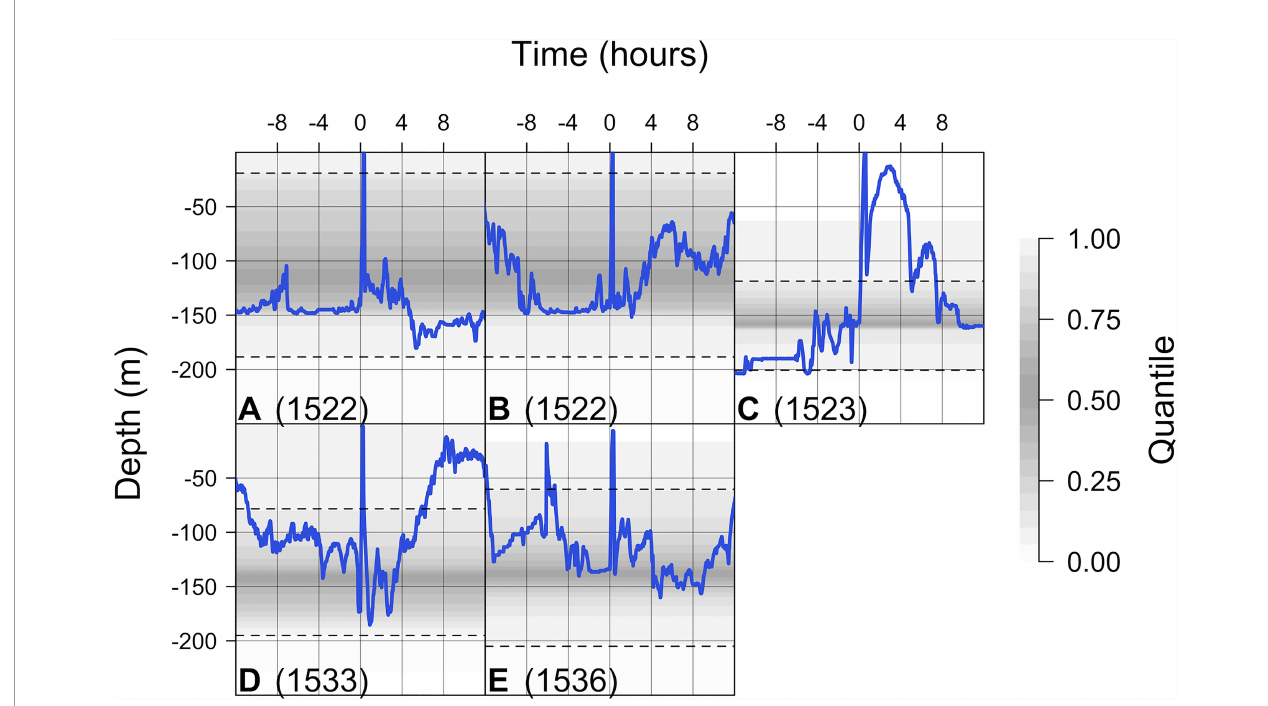
FIGURE 3 | Depth time series around recreational catch-and-release events that occurred during individuals ’ time at liberty. Each plot (A – E) plot shows the observed time series (in blue) around a capture event for a speci fi c individual. The background shading marks the quantiles of observed variation in depth based on the rest of each individual ’ s time series, with quantiles near the middle of the distribution shaded more darkly than quantiles towards the edge of the distribution. The dashed lines mark the 25 th and 75 th quantiles respectively. Depth observations beyond these lines are considerably shallower or deeper than average, while depth observations beyond the shading are more extreme than observed outside of capture